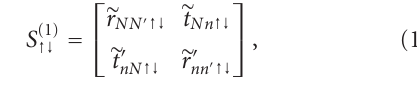
= ( m ∗ α (cid:25) W/ 2 = − W/ 2 φ N ↑ ( ↓ ) ( αx )